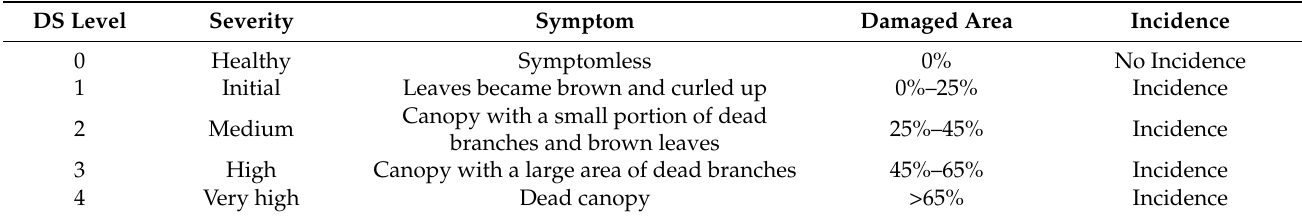
Table 1. Pests and diseases evaluation